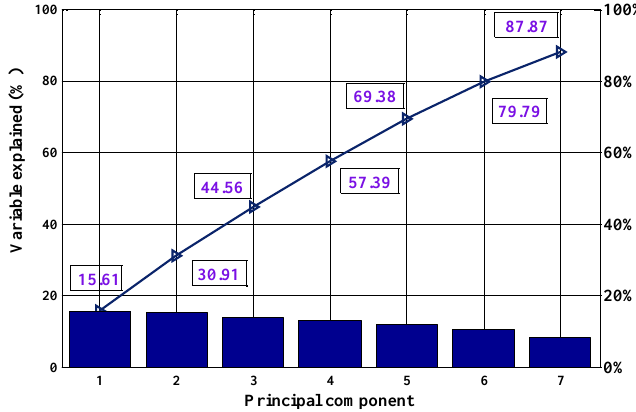
Figure 2. Variance explained based on principal component analysis. Appl. Sci. 2018 , 8 , x Table 3. Number related variables and factor interpretation.